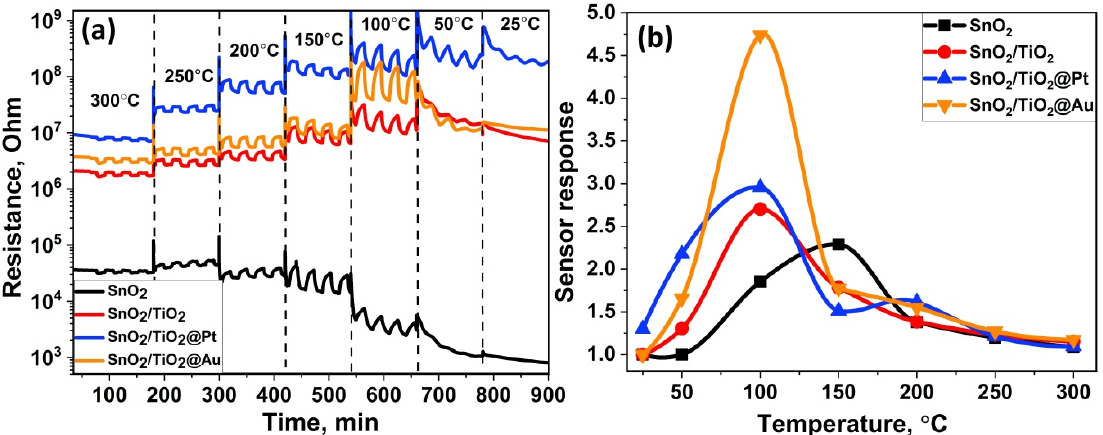
Figure 7. Change in resistance of the samples under periodic change of the gas phase composition in the temperature range of 300–25 °C ( a ); temperature dependencies of the sensor response of nanocomposites toward 1 ppm HCHO ( b ).